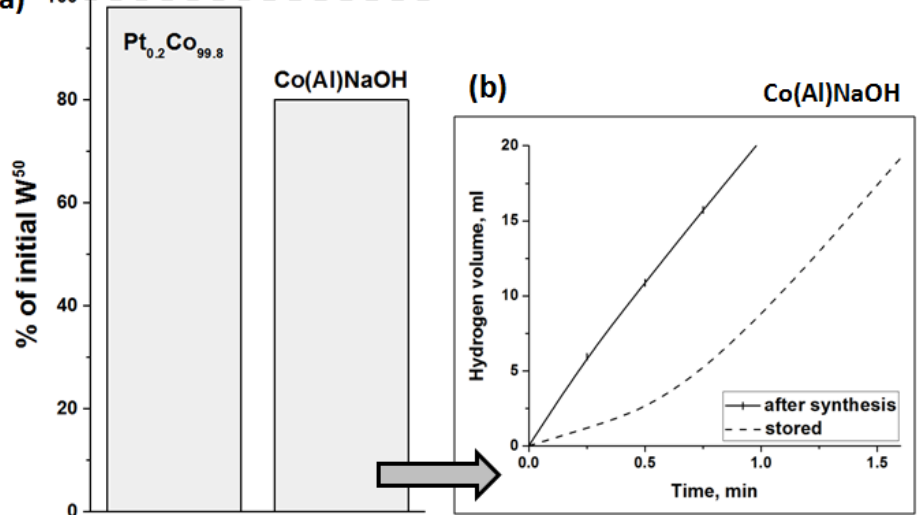
Figure 7. Pt 0.2 Co 99.8 and Co(Al)NaOH storage stability. ( a ) The catalytic activity of the catalysts stored in air for 1 month, expressed as % of the initial value of W 50 , determined during testing of freshly synthesized samples. ( b ) The initial stage of the hydrogen evolution in the presence of stored and freshly synthesized C о (Al)NaOH. T = 40 °C.